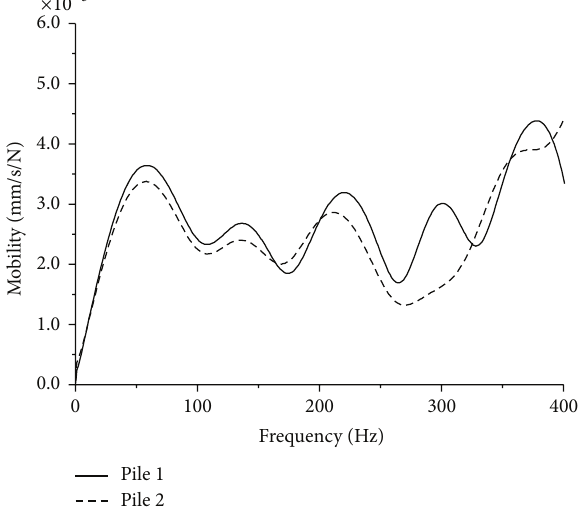
Figure 6: Typical mobility